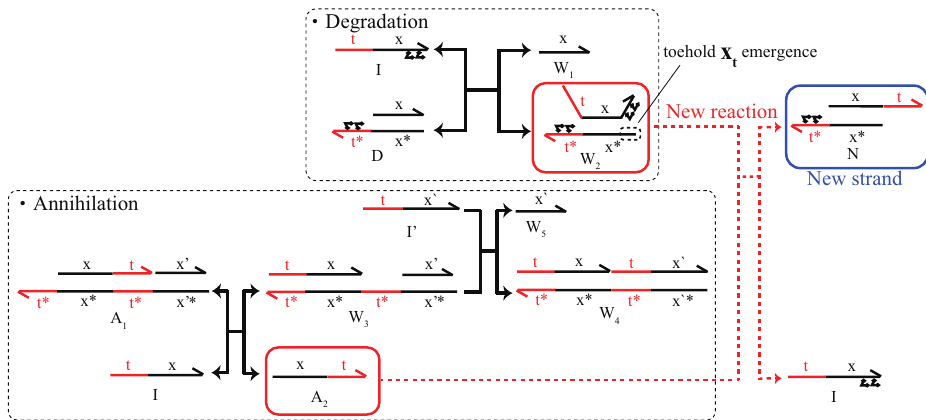
Figure 4. Unexpected reaction of azobenzene on annihilation and degradation